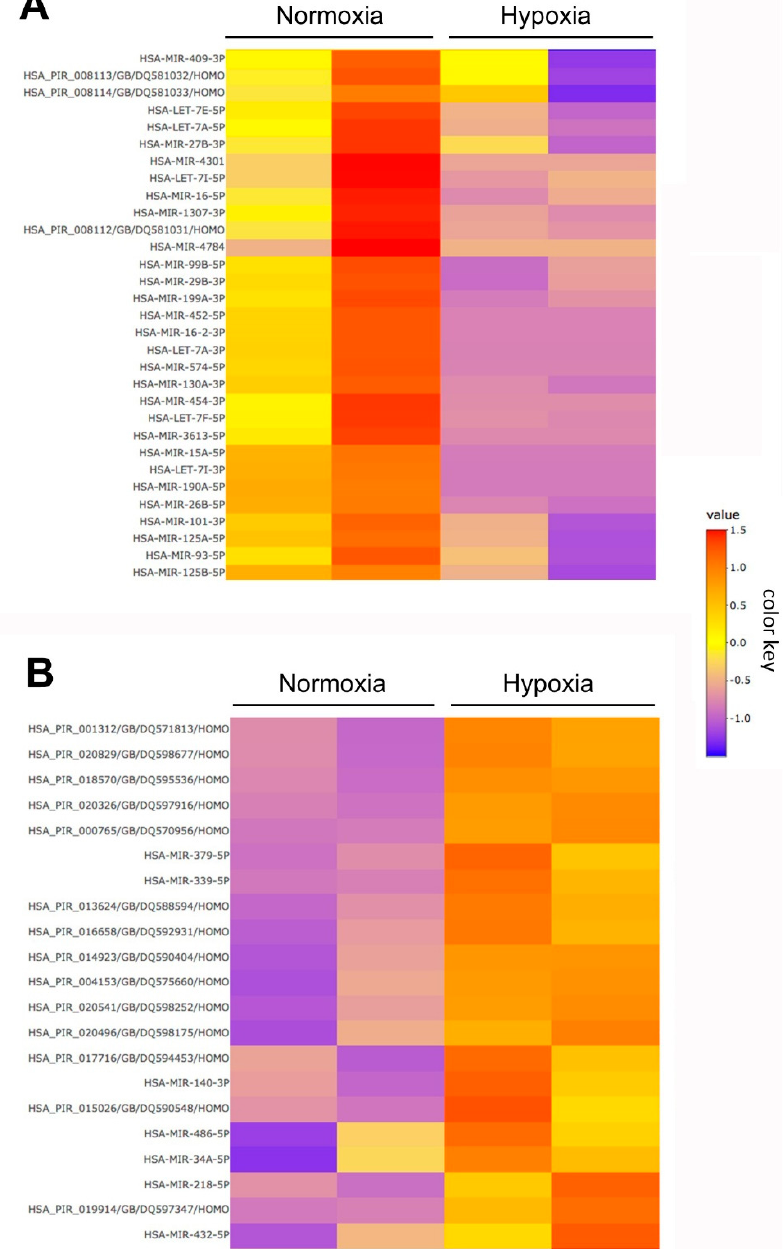
Figure 5. Analysis of miRs expression in ASC-EVs after hypoxic preconditioning. ( A ) Heatmap of selected down-regulated miRs after hypoxic pretreatment (significant and not significant hits). ( B ). Heatmap of selected up-regulated miRs after hypoxic pretreatment (significant and not signifi- cant